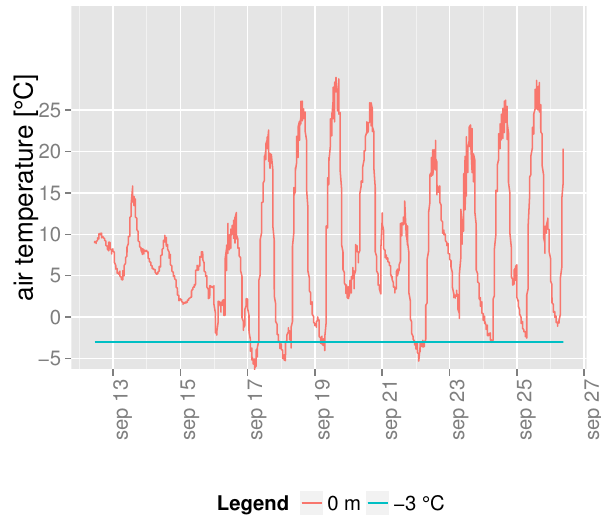
Figure 3. Air temperature at ground level measured in Junín, Mendoza in Spring 2013, showing several frost